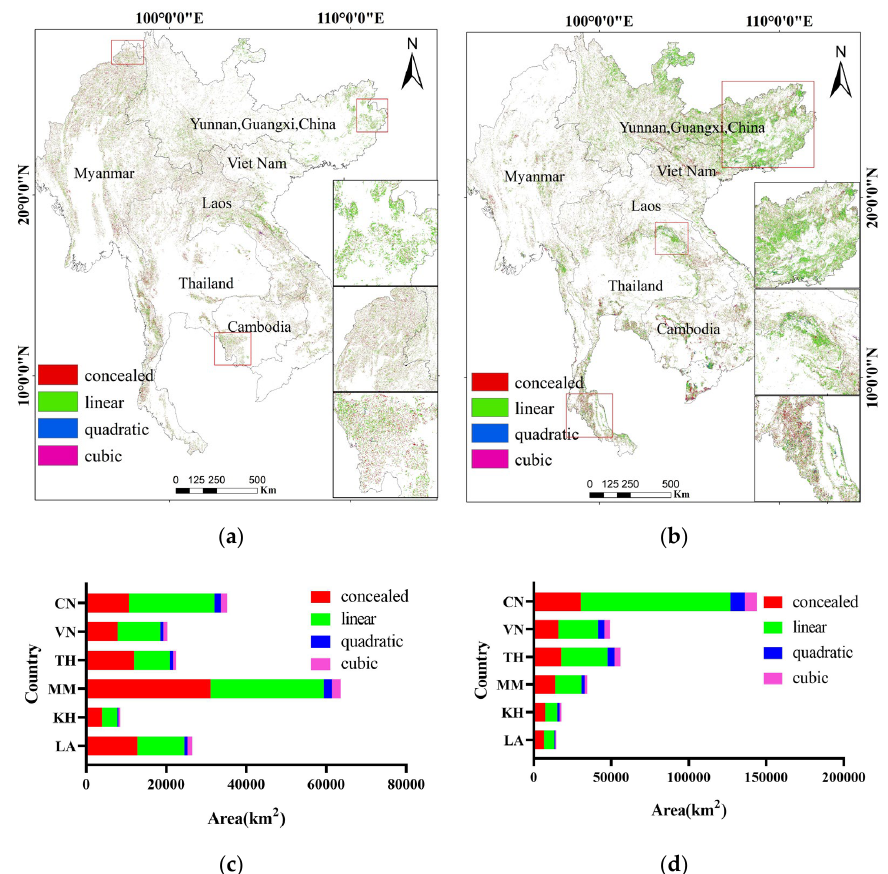
Figure 6. Area and spatial distributions of polynomial trends for forests and grasslands with no change type change: ( a , b ) spatial distributions of polynomial trends for forests and grasslands; ( c , d ) area distributions of polynomial trends for forests.